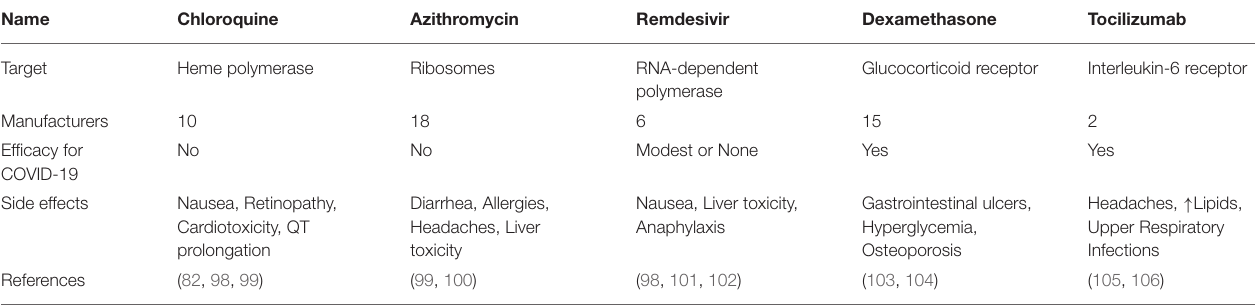
TABLE 4 | Efforts for drug